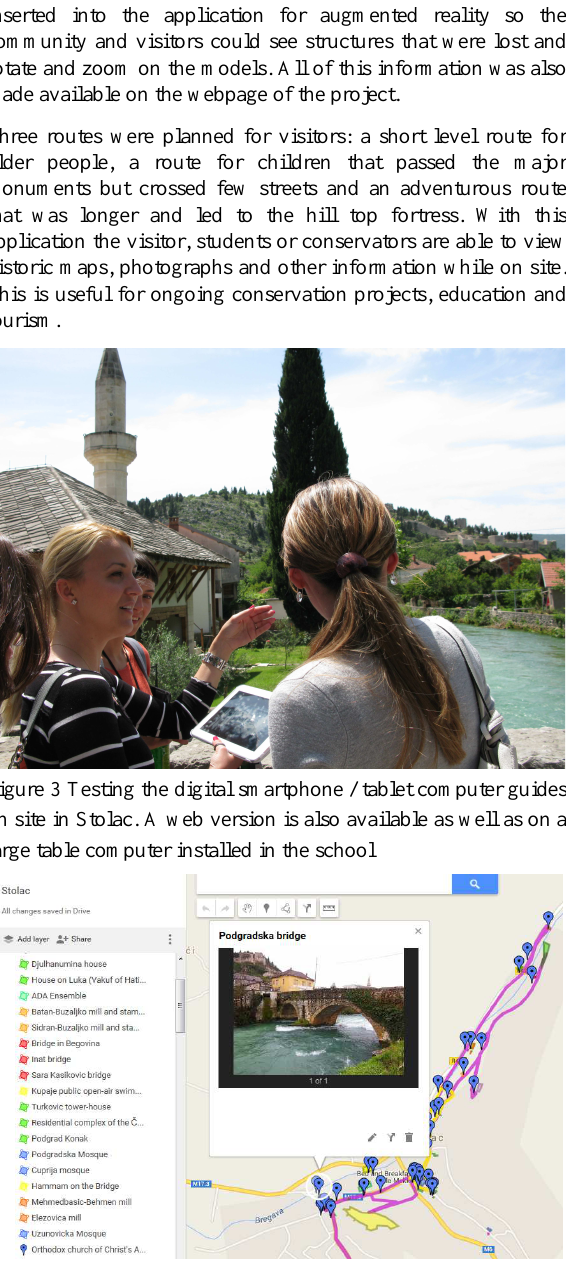
Figure 4 A resultant map created in real time during the course using participatory imaging mapping with names, categories and descriptions (Bridges to the Future,